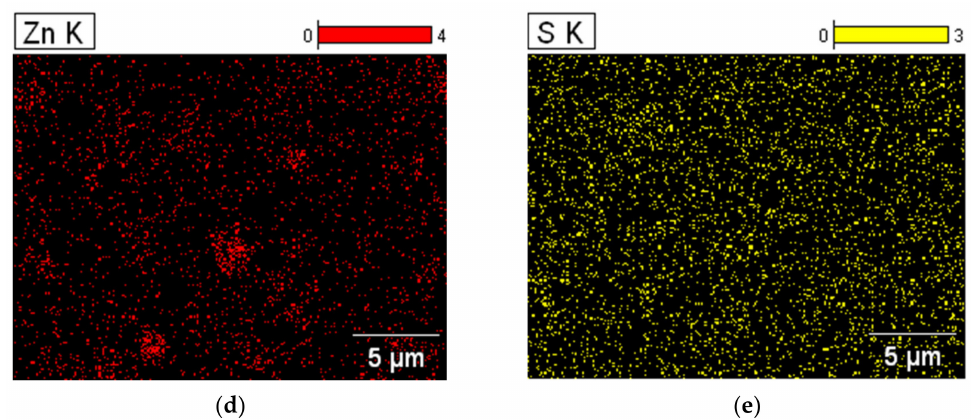
Figure 3. Scanning electron microscopy (SEM) image and Energy-dispersive X-ray spectroscopy (EDS) maps for A380-filled vulcanizate containing BmiBr: ( a ) SEM image; ( b ) EDS map for Si; ( c ) EDS map for Br; ( d ) EDS map for S; ( e ) EDS map for